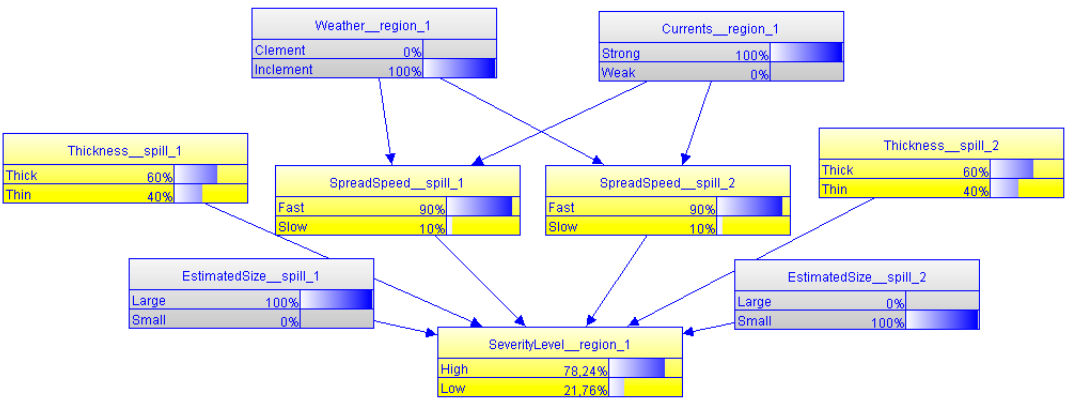
Figure 11. SSBN generated for the scenario with incomplete findings.